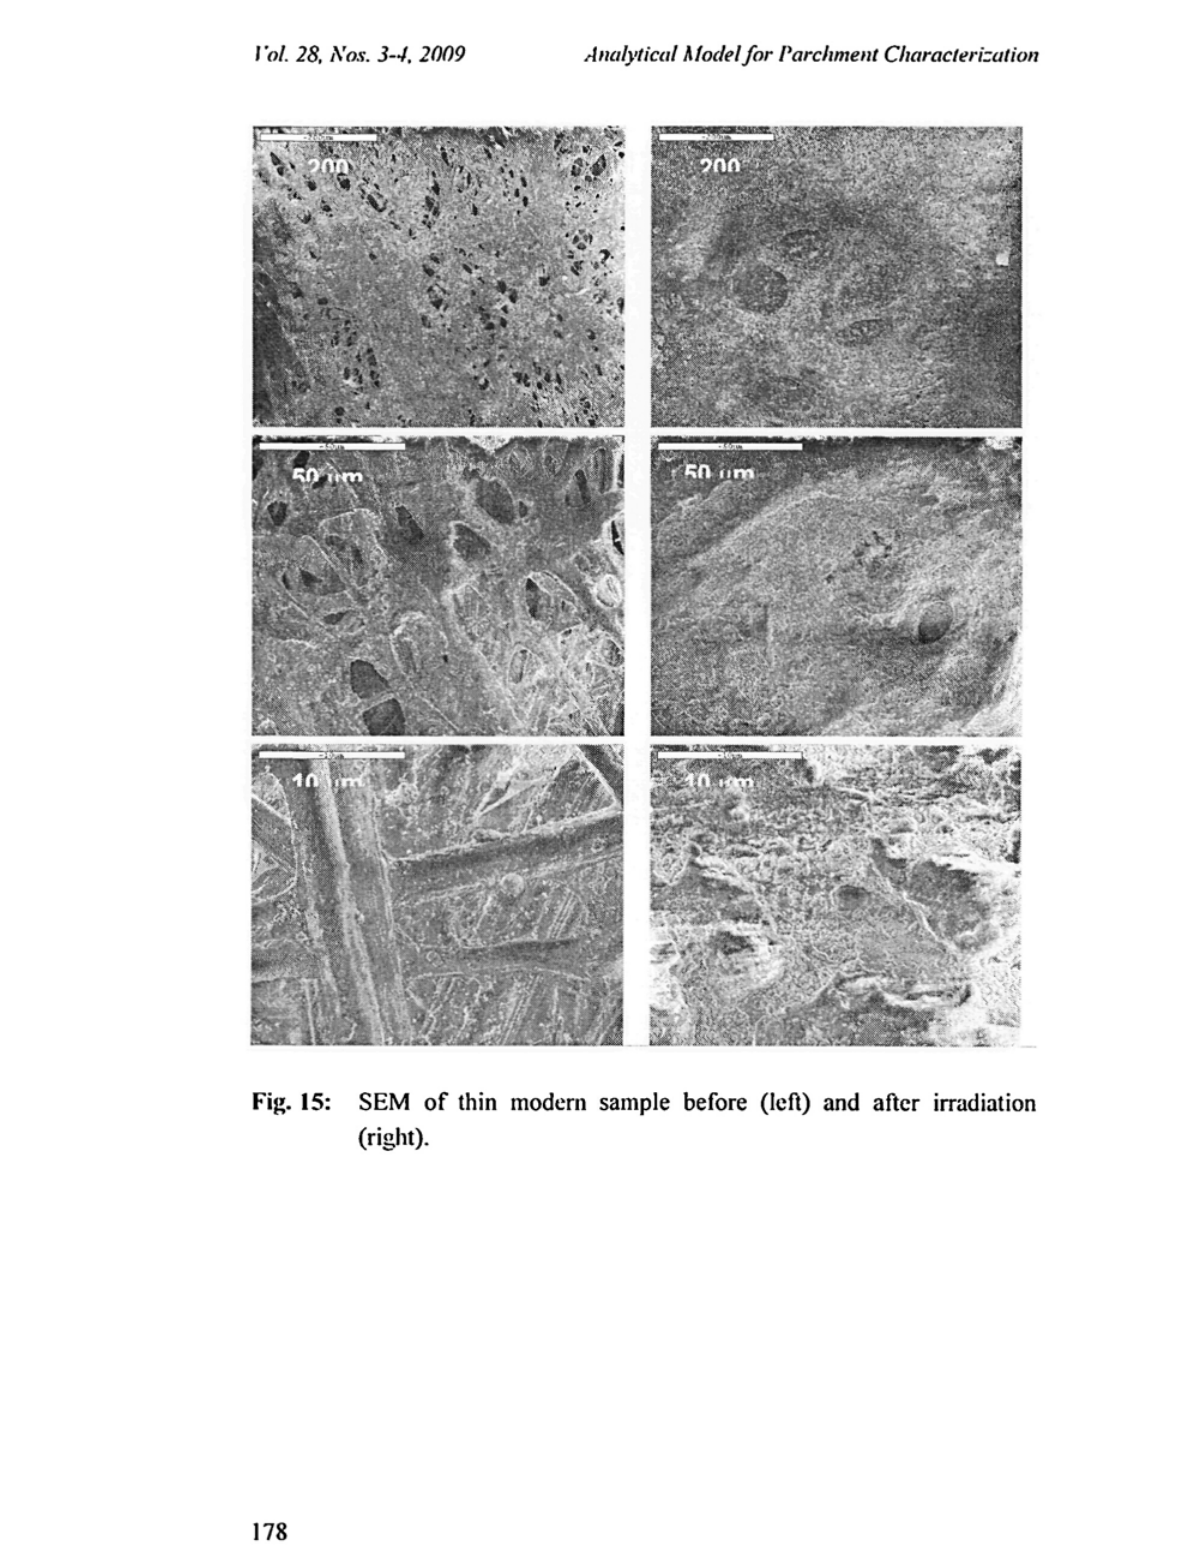
Fig. 15: SEM of thin modern sample before (left) and after irradiation